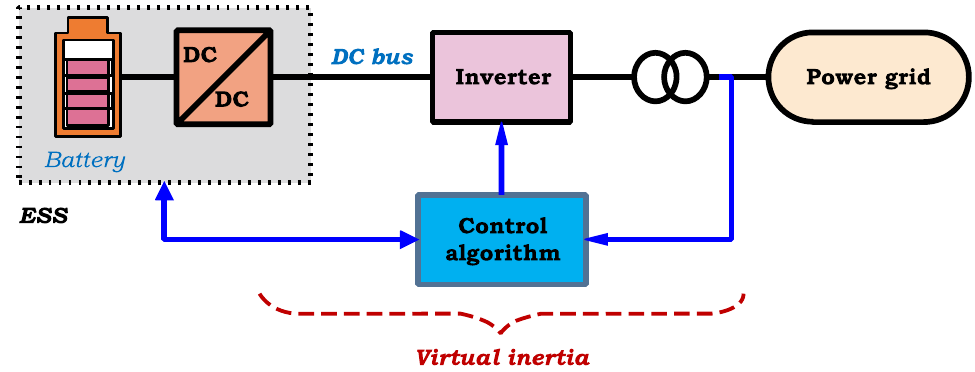
Figure 6. Schematic diagram of grid-connected virtual inertia system.